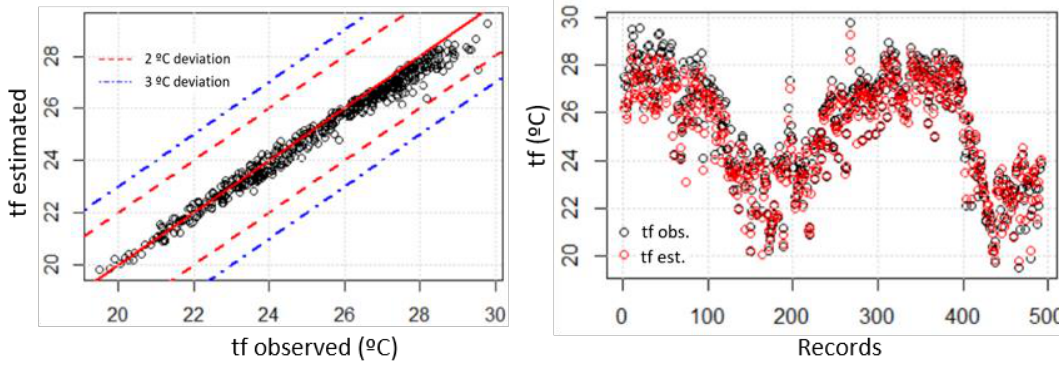
Figure 9. Analysis of temperature correlation and deviation between nodes 6 and 7.